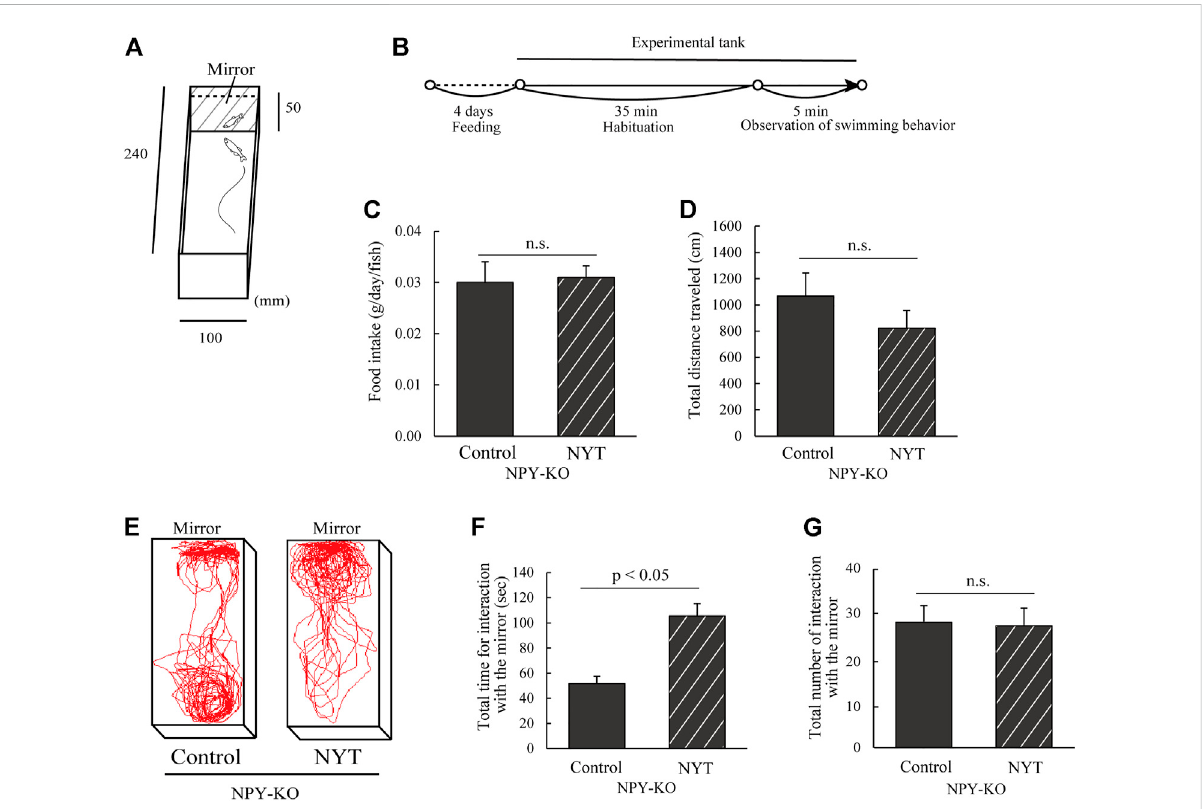
FIGURE 1 Effect of NYT on social behavior on mirror test in NPY-KO zebra fi sh. NPY-KO zebra fi sh were fed a control or NYT-diet twice daily for 4 days. Their social behaviors, such as interaction with the mirror and swimming distance, were estimated using a mirror test. (A) Mirror test apparatus. (B) Experimental scheme for behavioral evaluation. (C) Daily food intake. (D) Total distance traveled. (E) Tracking of control (left) and NYT-fed zebra fi sh (right)swimmingbehavior. (F) Totaltimeforinteractionwiththemirror. (G) Totalnumberofinteractionswithmirror. n =8.Resultsareshownas mean ± standard error of the mean. n.s., not signi fi